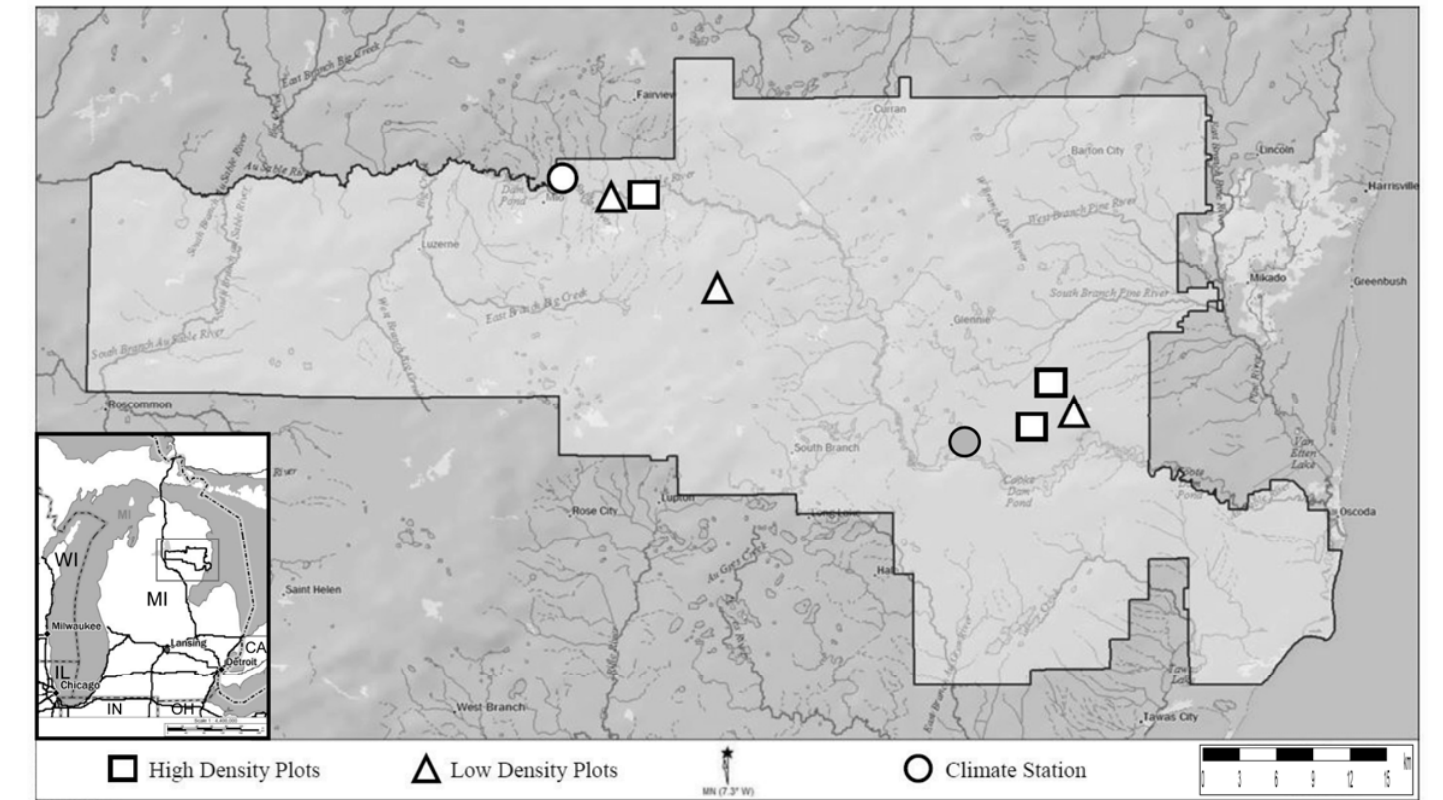
Figure 1. Locations of sample sites and climate stations within the Huron National Forest in the lower peninsula of Michigan. The climate stations are located in Mio (open circle) and Hale Loud Dam (gray circle). The inset figure shows the location of Huron National Forest (forest boundary enclosed by gray rectangle) within Michigan (MI) and neighboring states (IL = Illinois, IN = Indiana, OH = Ohio, WI = Wisconsin) and countries (CA =